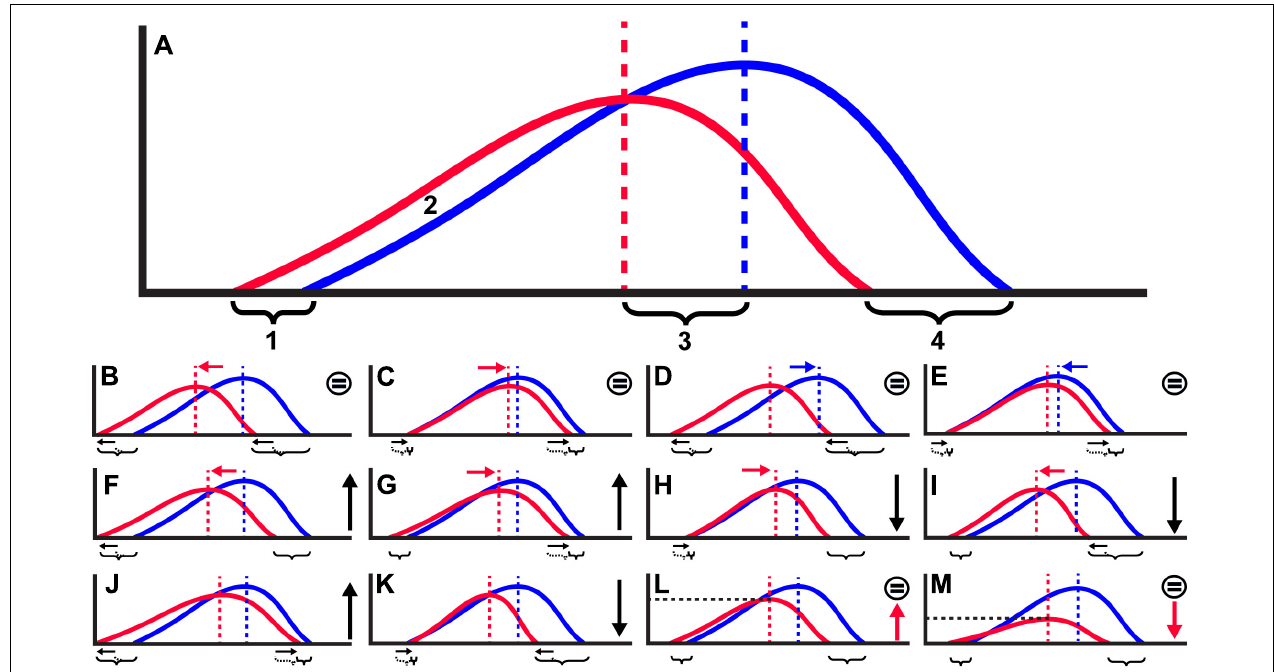
FIGURE 3 | Hypothetical distributions of repair scar sizes (SAA) (red line) and overall prey body size (blue line) as they relate to both predator success and comparability of repair frequency (RF) between samples. (A) Null distributions of SAA vs. body size used to compare with other scenarios (figure panels). Potential measures of success for comparison: [1] distance between minimum SAA (5th percentile) and body size (minimum size at which predators are likely to fail, resulting in a repair – note that crabs may still attack smaller prey, but below [1], attacks must be successful, as repairs do not occur), [2] proportion of repairs below the minimum repair size, [3] distance between mean SAA and prey size, and [4] distance between the maximum SAA (95th percentile) and prey size (indicating the largest prey the predator is able to attack, as well as the prey in a size refuge from predation). There may also be additional scenarios and relevant measures other than [1] – [4] to those shown. Red arrow = changes in predator strength, blue arrow = changes to prey size. (B–E) Because the shift in the distribution of SAA or prey size is proportional ([1] and [4] remain relative), RF is not affected (equal symbol to right of graph), even if success changes. (F–K) Scenarios where the shift in the distribution of repairs is not proportional, indicating that RF might be affected (black arrows to right of panel indicate whether RF is greater or less than expected). (L,M) If distributions of SAA and prey size are relative between samples, changes to RF indicate differences in the number of attacks (red dotted line).